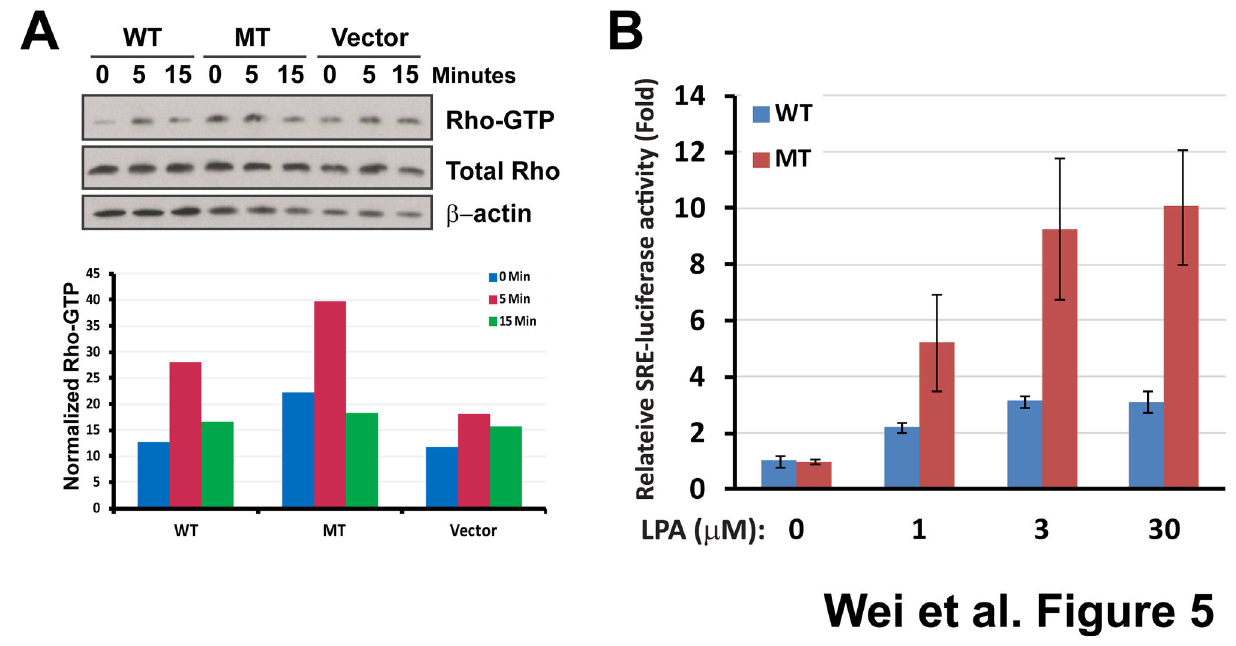
Figure 5. LPAR1 (R163W) mutation promotes cell mobility through activation of Rho pathway. ( A ) Rho activation assays (upper panel) showed a transient increase of GTP-bound Rho after exposure to LPA ligand (10 μM) in both wild-type (WT) and mutant (MT) LPAR1 expressing NIH3T3 cells indicating activation of Rho pathway mediated by the receptors. Signal of immunobands in the Western blot (upper panel) was quantified, and abundance of the GTP-bound Rho is plotted after normalization against total Rho and β-actin in the lower panel. ( B ) MT LPAR1 showed heightened signaling through the Rho pathway in transiently transfected COS-7 cells exposed to LPA in a dose-response way ( P <0.05) compared to WT. SRE represents the serum response element activity normalized against renilla luciferase and vehicle control. Error bars represent standard errors. doi: